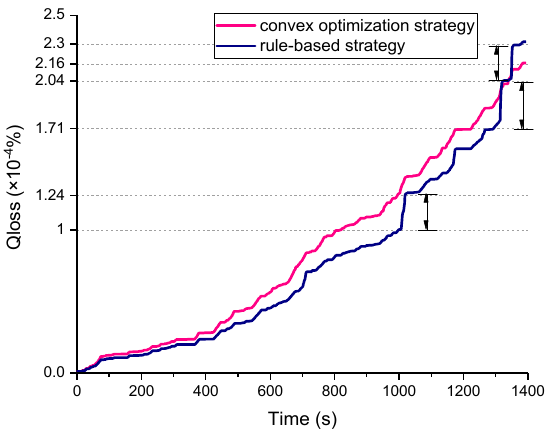
Figure 16. The percentage of battery degradation under two strategies. Table 5. The indicators of two strategies under one cycle line.